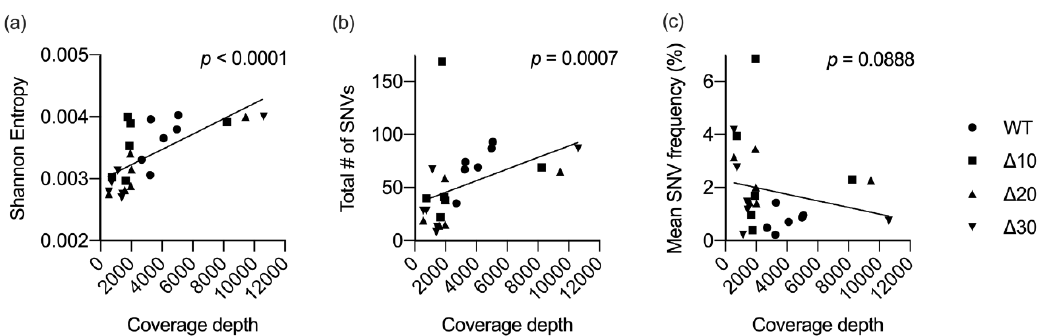
Figure 3. Correlation between sequence coverage and diversity. For each virus in the study ( n = 24), mean coverage depth was plotted against mean Shannon entropy ( a ), total number of SNVs ( b ), or the mean frequency of all SNVs ( c ). Linear regression and nonparametric Spearman correlation tests were performed using GraphPad Prism V8.